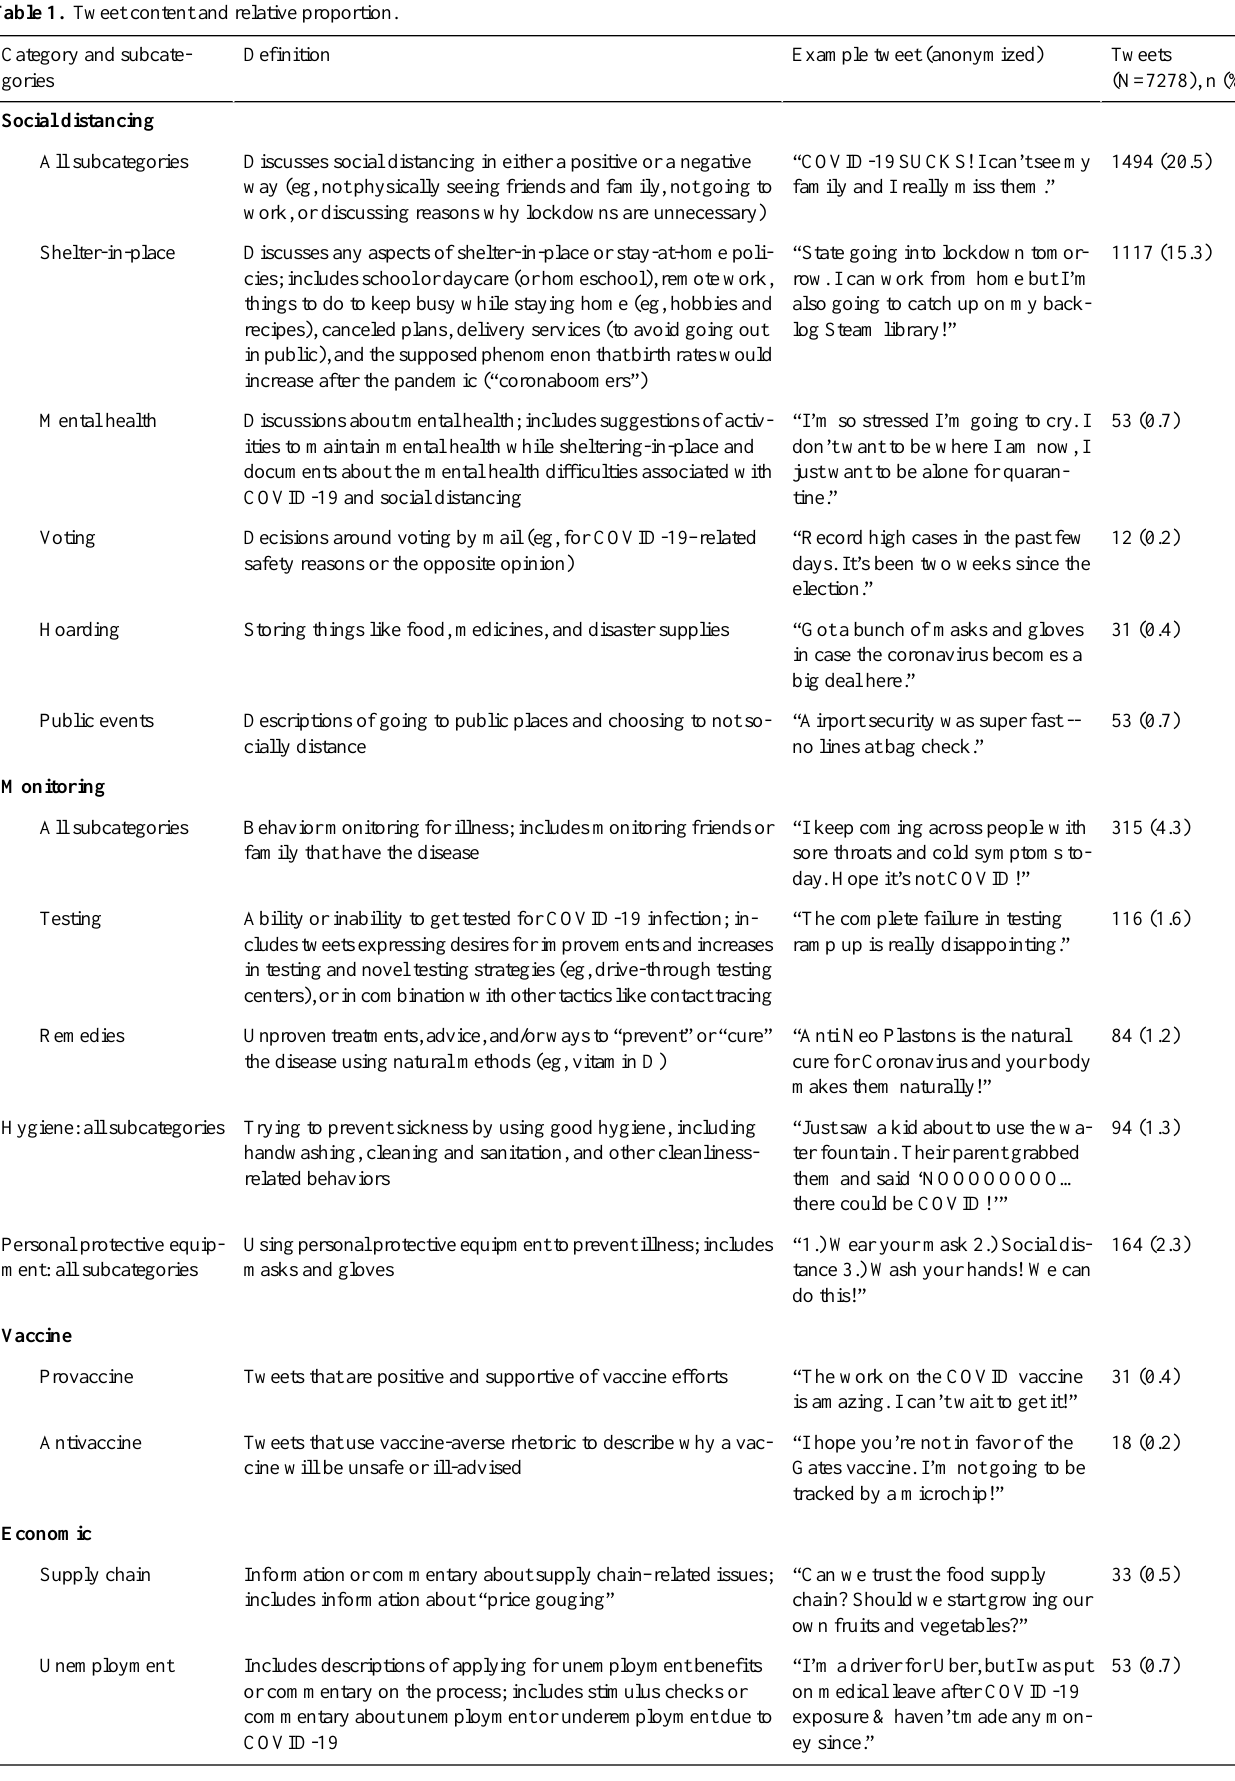
Table 1. Tweet content and relative proportion.